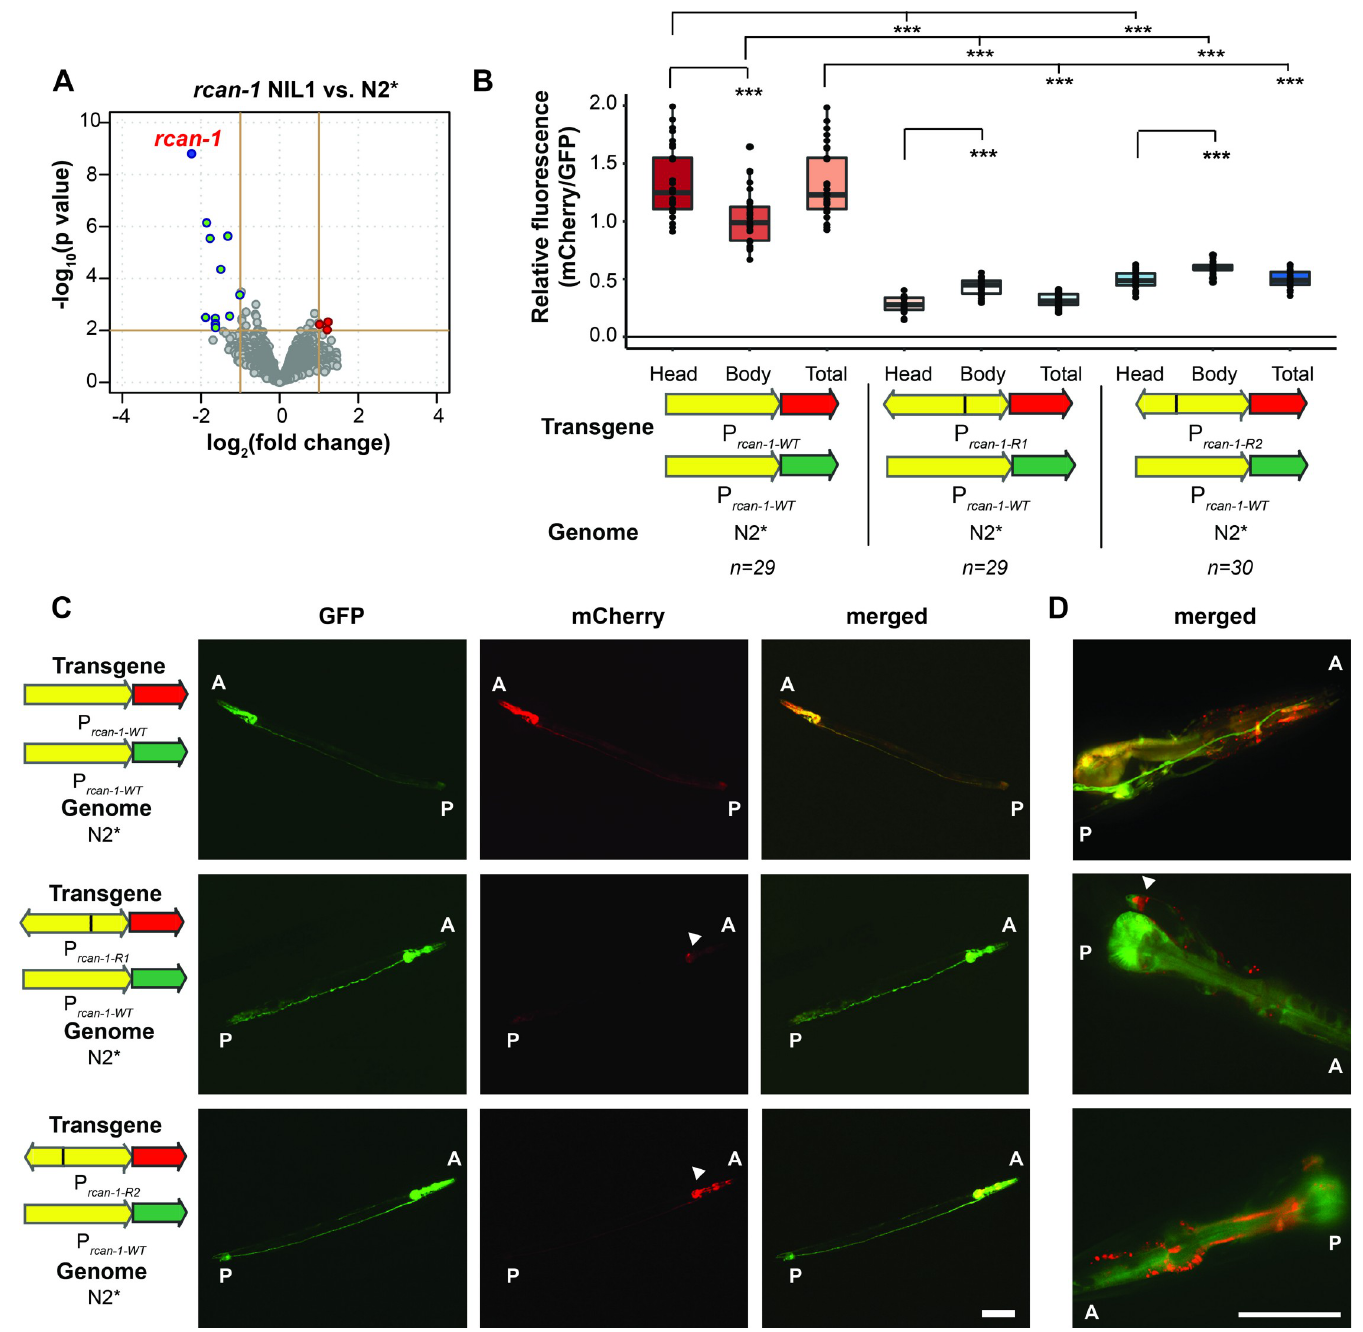
Fig 6. The rcan-1 rearrangement allele decreases expression of rcan-1 . (A) A volcano plot of expression differences between the rcan-1 NIL1 and N2 � strains. RNA was isolated from synchronized, L4 animals. The gene with the largest and most significant expression decrease was rcan-1 . Red: p < 0.01, log 2 (Fold Change) > 1. Cyan: p < 0.01, log 2 (Fold Change) < -1. (The list of differential expressed genes with significance are available in S5 Table ). (B) Co-injection of wild-type rcan-1 promotors driving GFP with wild-type rcan-1 or rearranged rcan-1 upstream promoter regions driving mCherry created from the RIL hf strain. Each dot represents the ratio of total GFP expression divided by total mCherry expression from a single animal. Fluorescence was also segmented into head or body expression and compared separately ( ��� : p < 0.001. one-way ANOVA tests followed by Tukey’s honest significant difference test. The top comparison group refers to the head fluorescence signal of the two truncated rcan-1 promoters compared to head of wild-type rcan-1 ). (C) Representative fluorescence images of (B). The white arrow in the middle panel indicates the neurons that retain high level of expression of mCherry driven by P . The white arrow in the bottom panel indicates the expression of mCherry driven by P rcan-1-R1 rcan- 1-R2 in the head region. Scale bar is 100 μ m. (A: anterior; P: posterior). (D) Representative fluorescence images of the head showing a pair of interneurons with less affected expression. (These are different animals from C). The white arrow in the middle panel indicates the neurons that retain high level of expression of mCherry driven by P rcan-1-R1 . Scale bar is 50 μ m. (A: anterior; P: posterior).